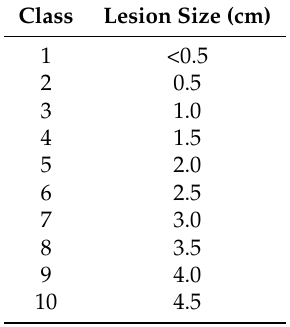
Table A1. Lesion size